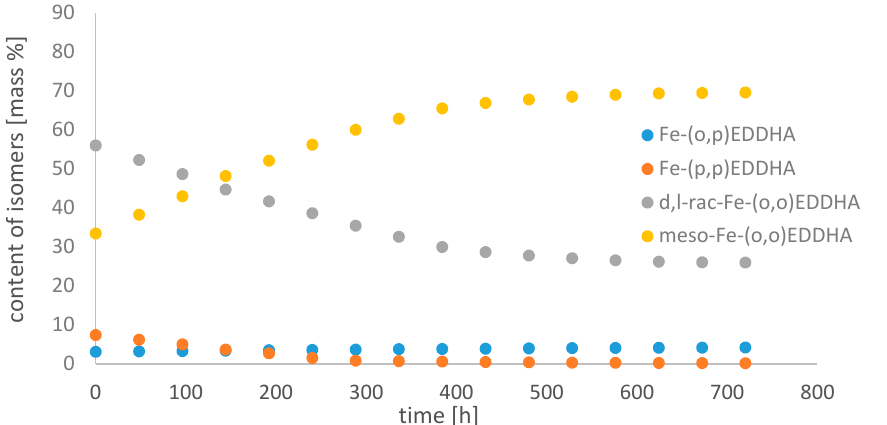
Figure 8. Change in the content of iron(III) ethylenediamine- N,N ′ -bis(hydroxyphenylacetic) acid isomers with time in an aqueous solution at pH 3.